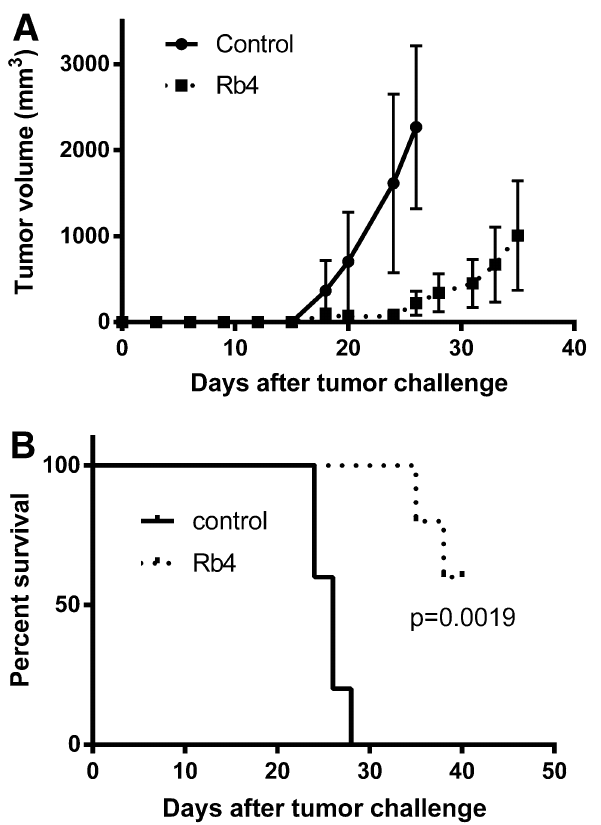
Figure 3. Effect of Rb4 on the protection against subcutaneous melanoma in C57Bl/6 mice. ( A ) Tumor growth curve and ( B ) Percent survival. Control: mice inoculated with vehicle. The graphic represents one of three independent experiments (n = 5). The long-term survival was recorded according to Kaplan–Meier analysis and log-rank (Mantel–Cox) test. Error bars represent the mean ±